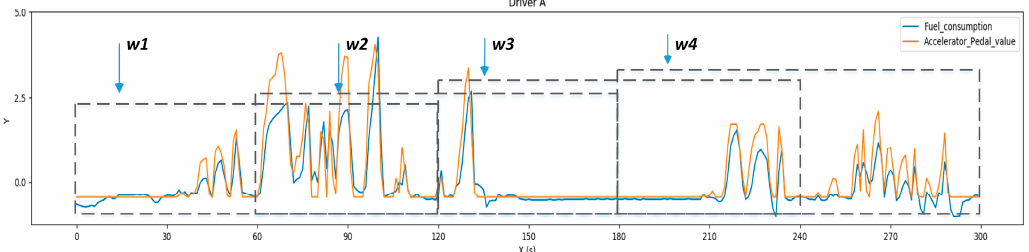
Figure 4. Overlapping sliding window method. Four windows ( w 1 , w 2 , w 3 , w 4 ) were obtained from the 300 samples when setting the window size T x to 120 samples and time step ∆ t to 60